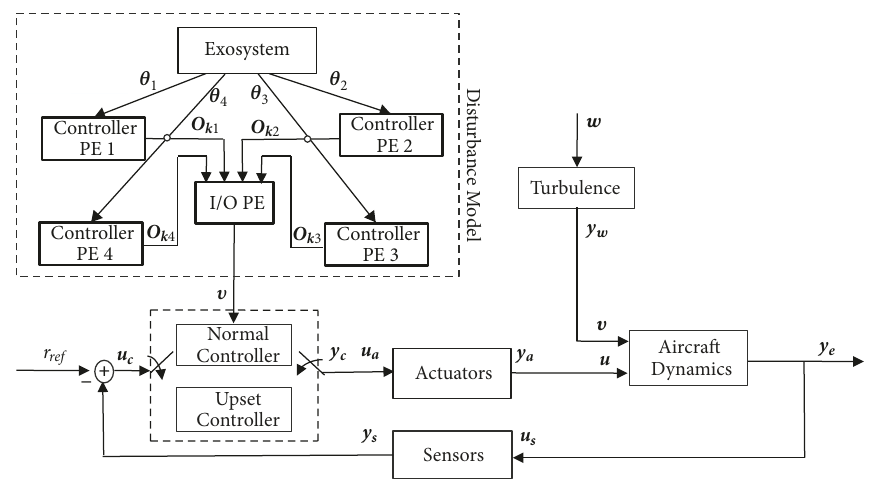
Figure 1: Scheme of flight control system subject to digital